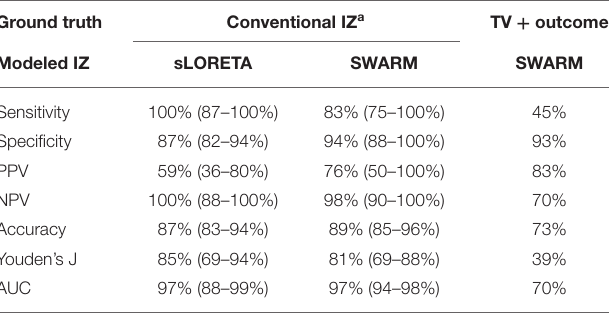
TABLE 2 | Test statistics for agreement of modeled irritative zone with conventional irritative zone of seizure-free patients and with treatment volume of seizure-free vs. non-seizure-free